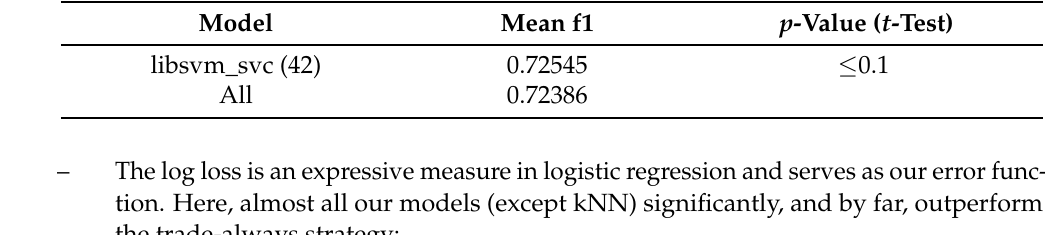
Table A11. Models with significantly better mean F1.